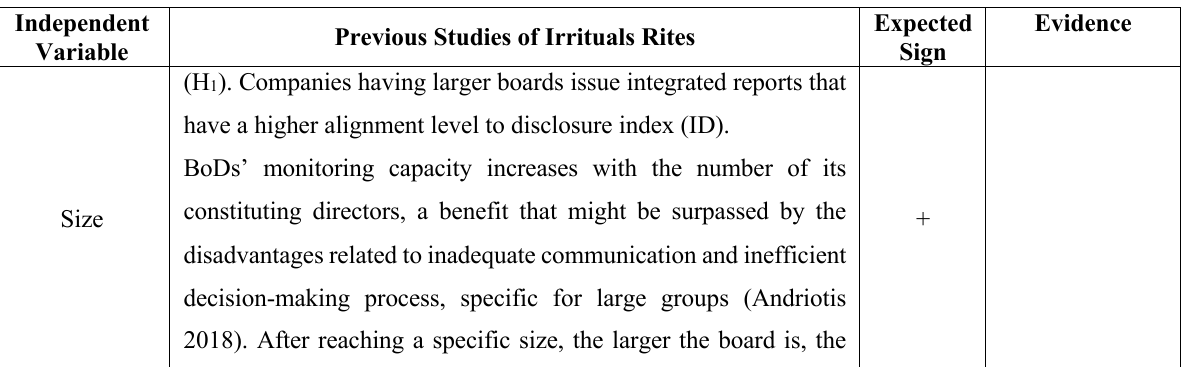
Statistical Quantities